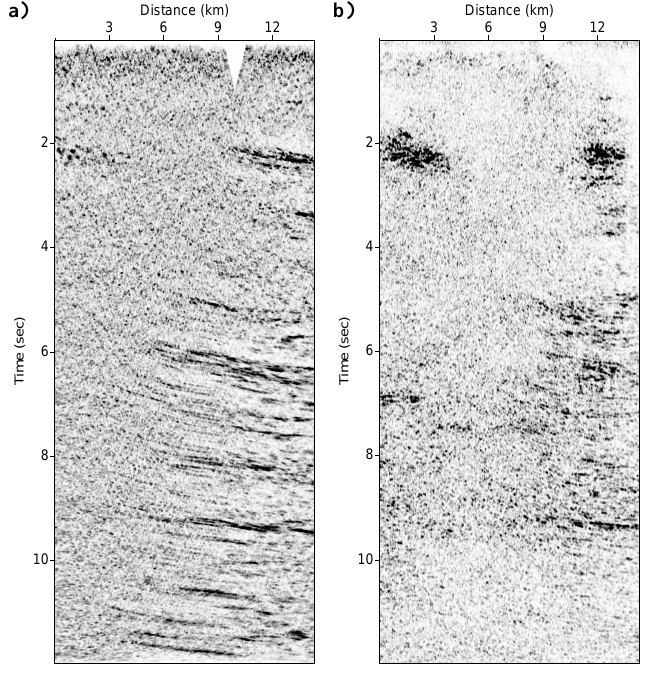
Figure 9. Comparison betweem the overlapped portions of Metal Earth’s Larder Lake R1 Pre-stack migrated section ( a ) and Lithoprobe’s AG-23 post-stack migrated section ( b